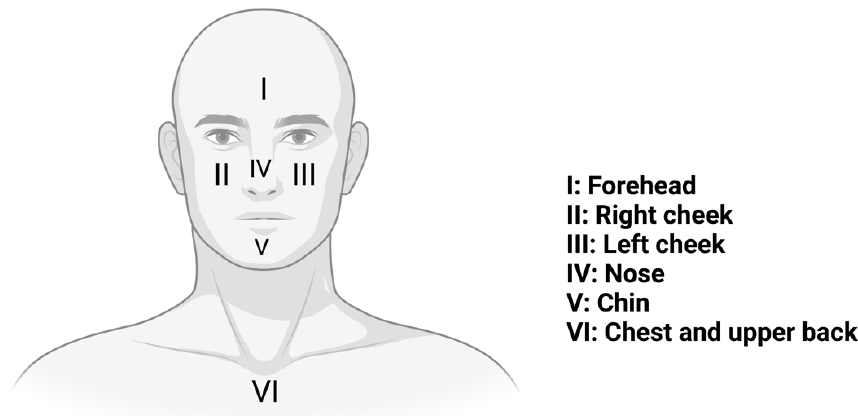
Figure 3. The six locations (I–VI) of the Global Acne Grading System (GAGS). After six months of Metformin treatment, Group A had a significant reduction in the GAGS score from 25.1 ± 8.9 to 14.1 ± 10.4, with a decrease in glucose values, 120 min after a 75 g Oral Glucose Tolerance Test (OGTT), without any mild or severe side effects. Group B did not report any significant improvement in GAGS (24.9 ± 7.6 to 19.4 ± 7.4) [46]. A study by Del Prete et al. examined the relationship between insulin resistance and other metabolic disorders in male acne patients [48]. This study comprised 22 boys with acne resistance to treatment, aged from 15 to 26 years, along with 22 healthy males of a comparable age who participated as the control group (Table 3). The results showed that the levels of total cholesterol, triglycerides, serum IGF-1 and testosterone were comparable between the two groups. In contrast to the control group, the patients with resistant acne disease had a higher BMI, blood insulin and glucose concentrations and lower HDL choles- terol. In all the patients with resistant acne disease, the androgenic profile was reported as normal [48]. These data suggested that the chief influence of high insulin and glucose levels, low HDL-cholesterol and adiposity (essentially metabolic syndrome) on acne disease in males was different from females, which is chiefly influenced by androgen production and action. These findings highlighted a strong relationship in the etiopathogenesis of acne disease between inflammation, insulin resistance and cholesterol levels, at least in